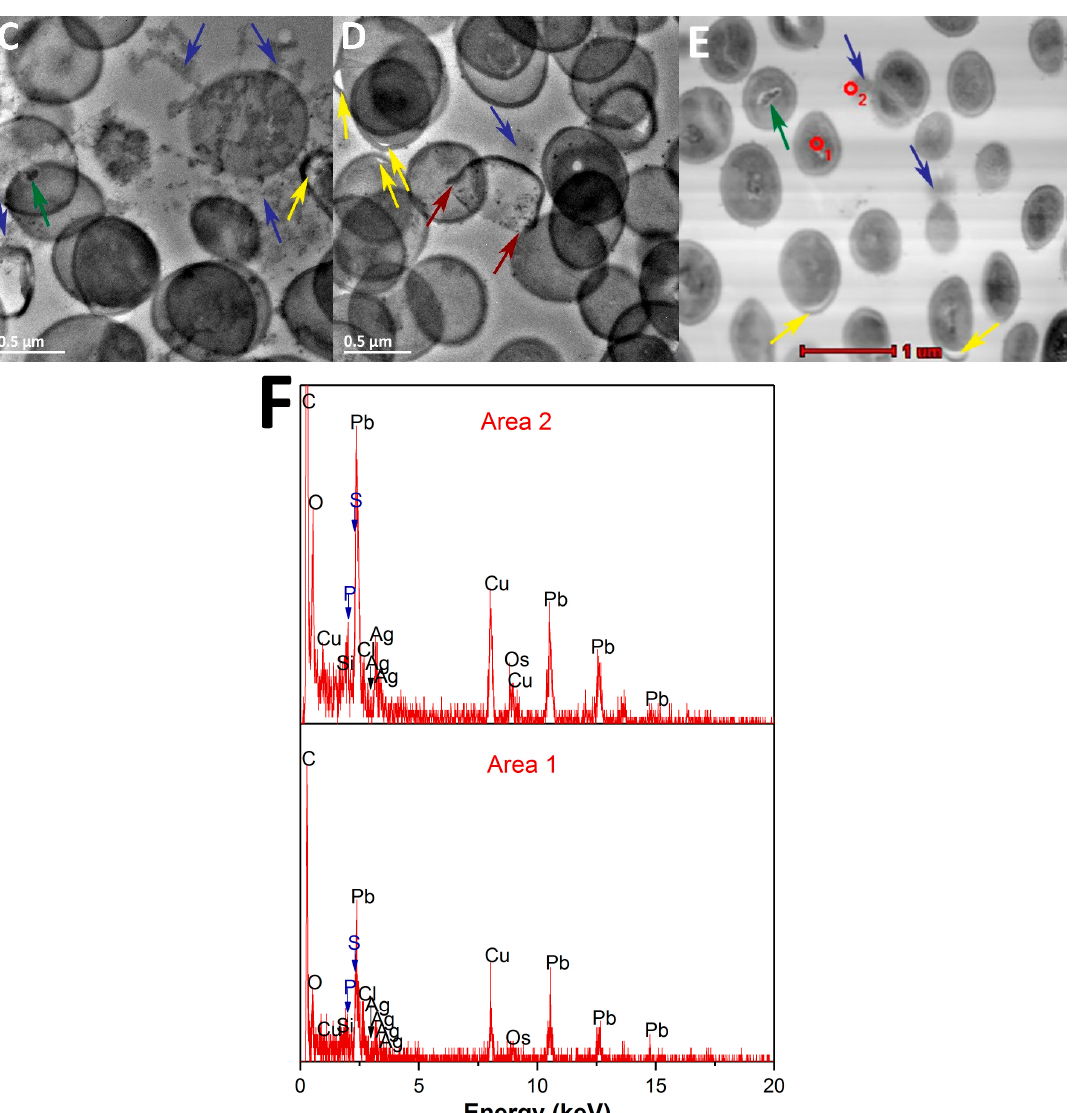
Figure 8. TEM images of ( A ) untreated MRSA; ( B ) MRSA treated with pristine SiO 2 NPs; and ( C , D ) MRSA treated with the Ag–SiO 2 composite; ( E ) HAADF-STEM image of MRSA treated with the composite; ( F ) The EDX elemental analyses of the selected areas 1 and 2 in panel E. Yellow arrows highlight the gaps between the cell walls and cytoplasmic membranes. Blue arrows show the release of cytoplasmic contents from the bacterial cells. Green arrows demonstrate the central condensation of the bacterial DNA. Red arrows indicate the disruption and loss of bacterial membranes.